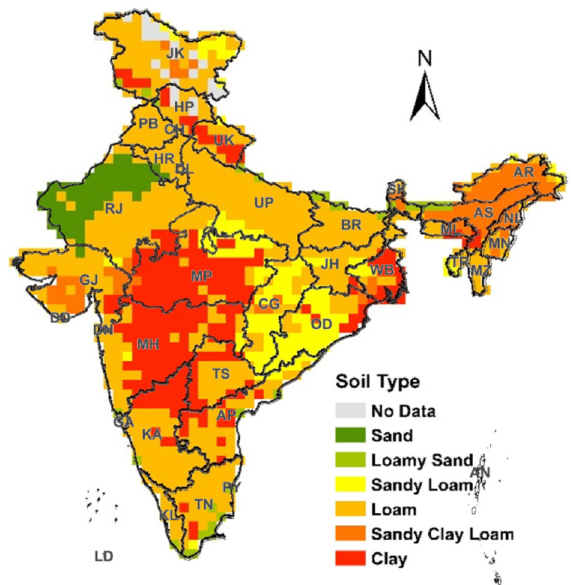
Figure 1. States and union territories (UT) of India with grid level soil type map derived from Harmonised World Soil Dataset (HWSD) (Spatial resolution of 0.5° latitude × 0.5° longitude equivalent to approximately 55 × 55 km grid size). The map was generated using Harmonized World Soil Database v 1.2 (http:// www. fao. org) in ArcGIS 10.8.1 (https:// www. arcgis. com/ index. html) (State/UT codes and names: AN Andaman and Nicobar,